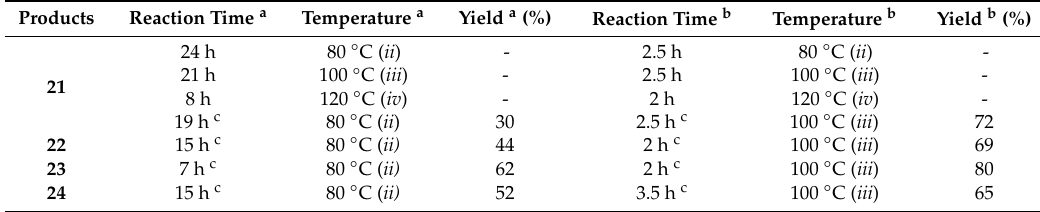
Table 3. Reaction conditions for the synthesis of the products 21 –